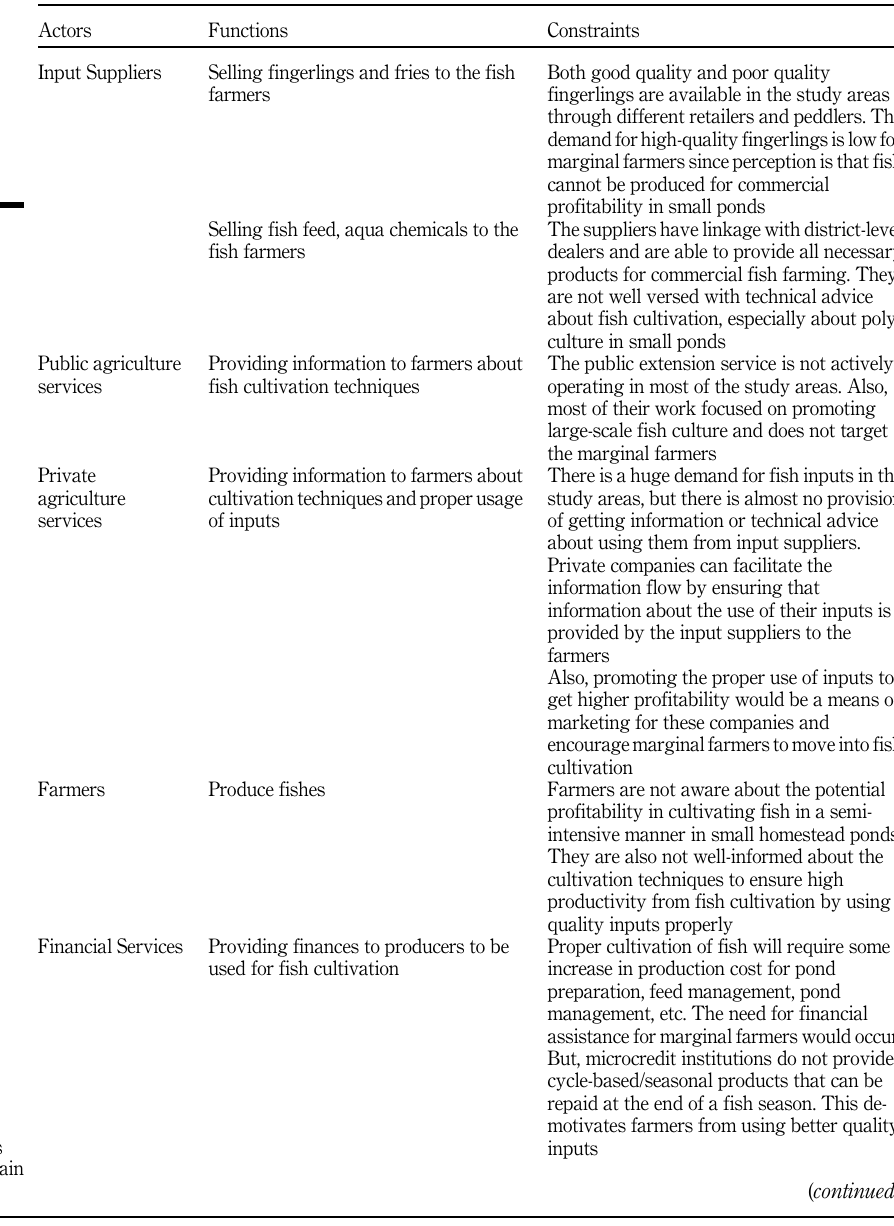
Table 16. Constraints analysis for the fish value chain in the study